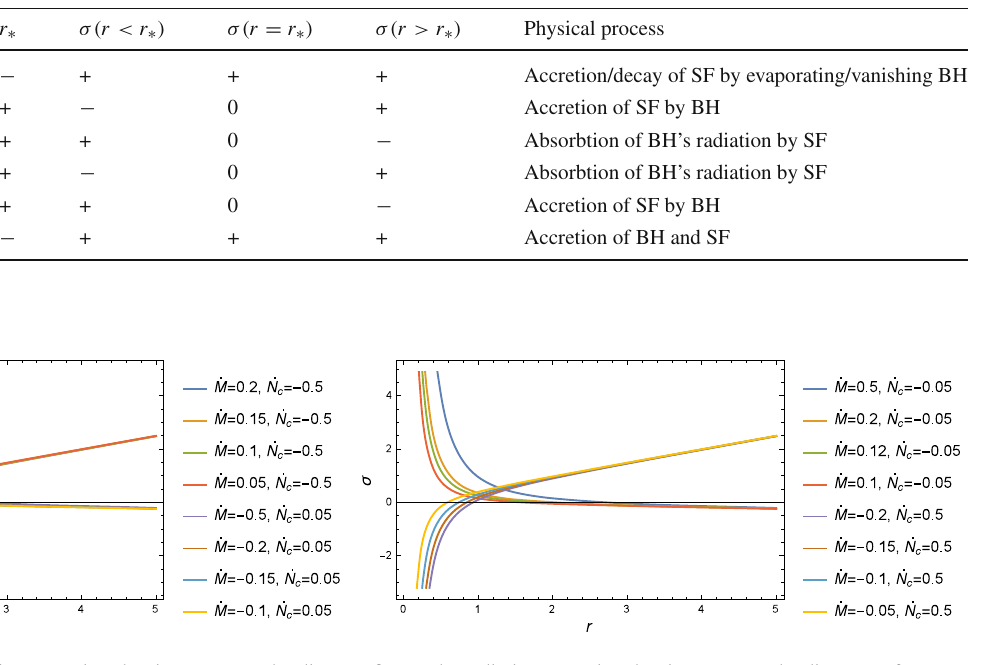
figure: the radiation-accretion density σ versus the distance r for some typical constant values ˙ M and ˙ N c values for (cid:5) = + 1 in the cosmo- logical background. In the four upper cases, the accretion density is a decreasing function from positive to negative values. In the four lower cases, the radiation density is an increasing function from negative to positive values. Then, for a dynamical cosmological background, if the condition | ˙ N c ( u ) | (cid:11) | ˙ M ( u ) | is not met, the positive energy condition is violated in some regions of